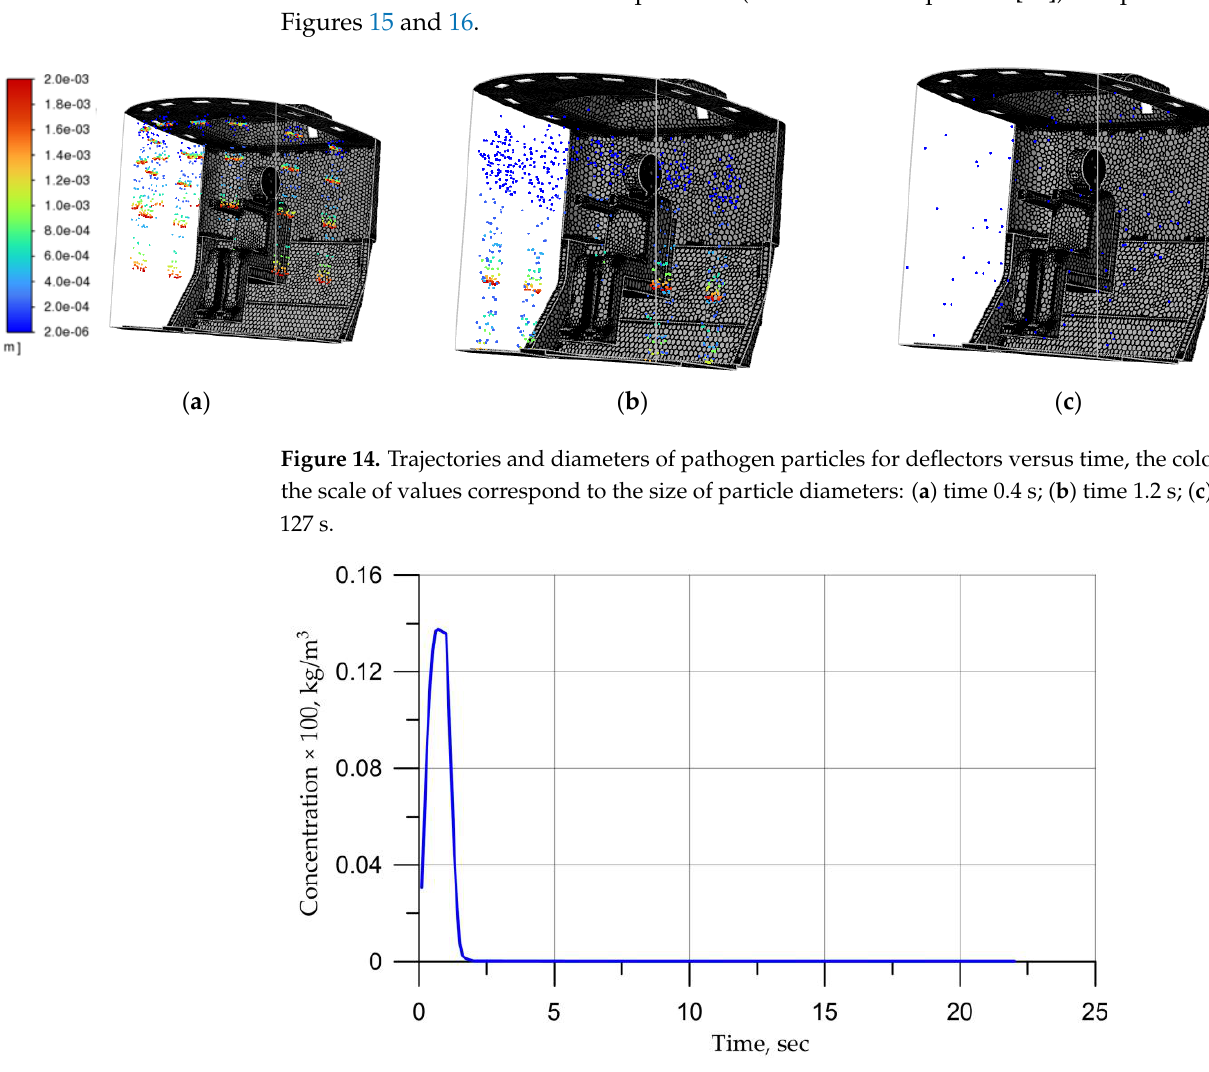
Figure 15. Particle concentration over time.